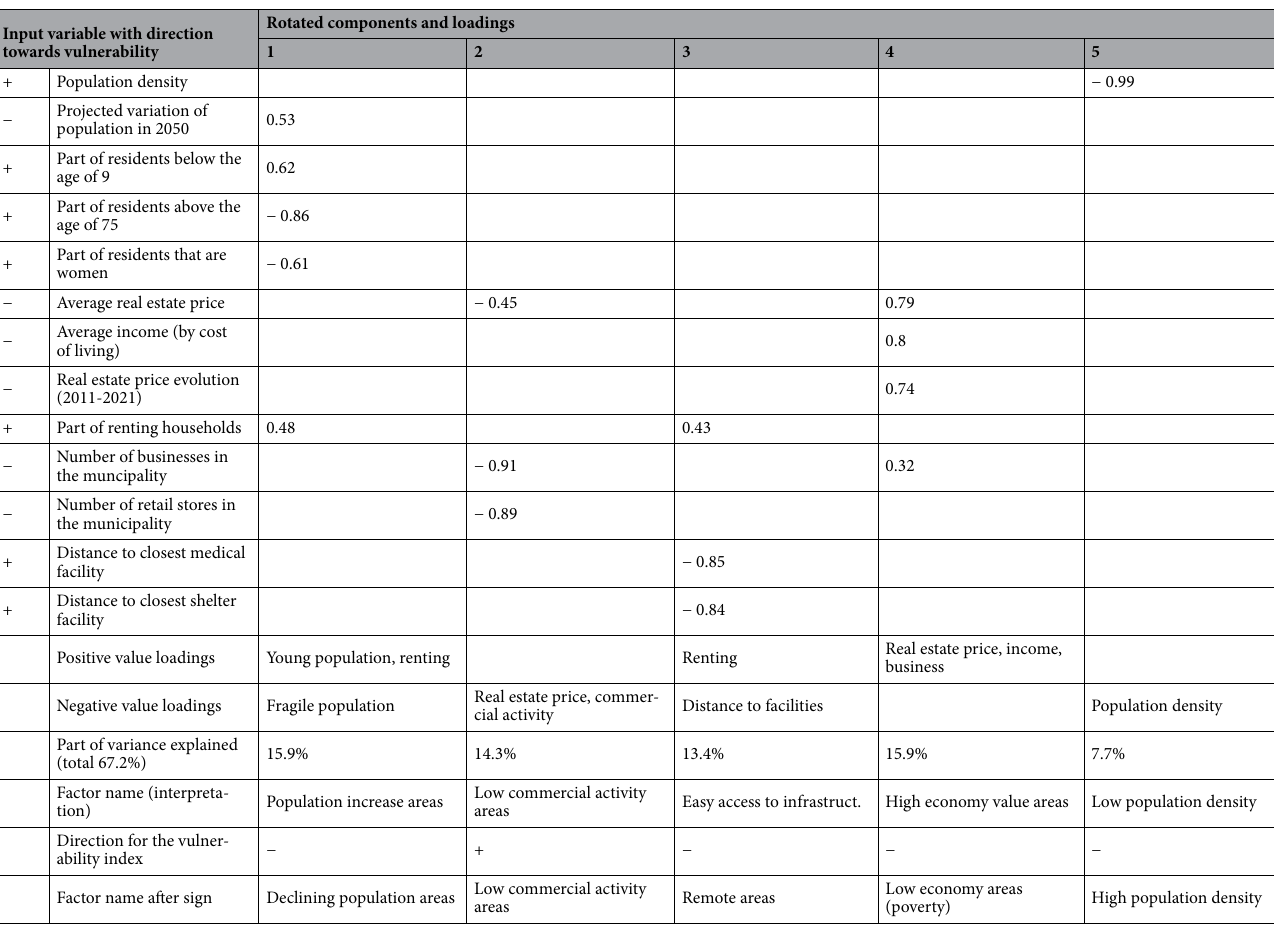
Table 3. Rotated component matrix of the principal component analysis showing the indicator loadings and each component